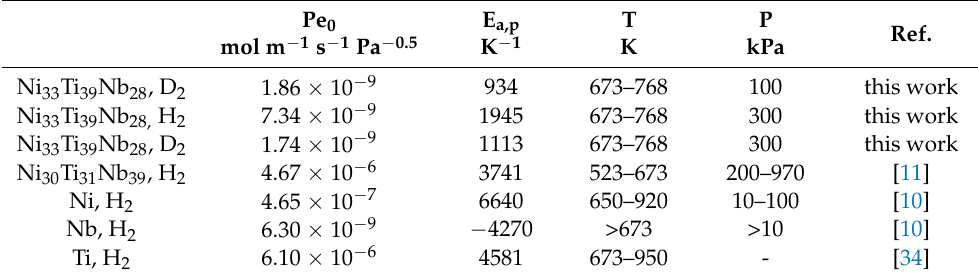
Figure 6. Calculated hydrogen and deuterium permeability for the presently investigated Ni 33 Ti 39 Nb 28 alloy and comparison with the literature (Ni [10], Nb [10], Ti [34], Ni 30 Ti 31 Nb 39 [11] and Ni 41 Ti 42 Nb 17 [11]). Table 1. Hydrogen and deuterium permeability of Ni 33 Ti 39 Nb 28 calculated at selected temperatures and pressures and comparison with the